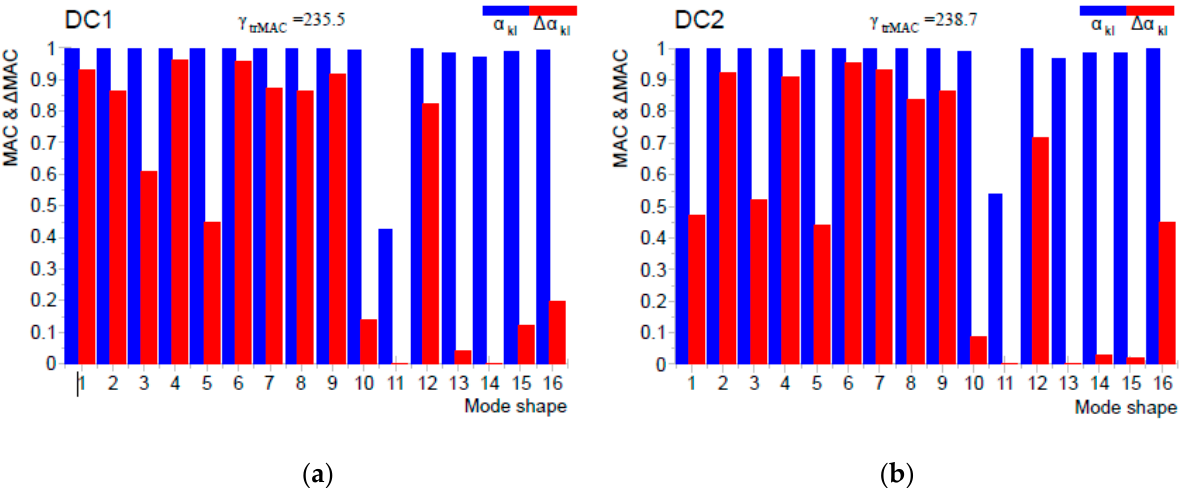
Figure 7. Diagonal elements of the MAC and Δ MAC matrices: ( a ) damage case DC1; ( b ) damage case DC2.